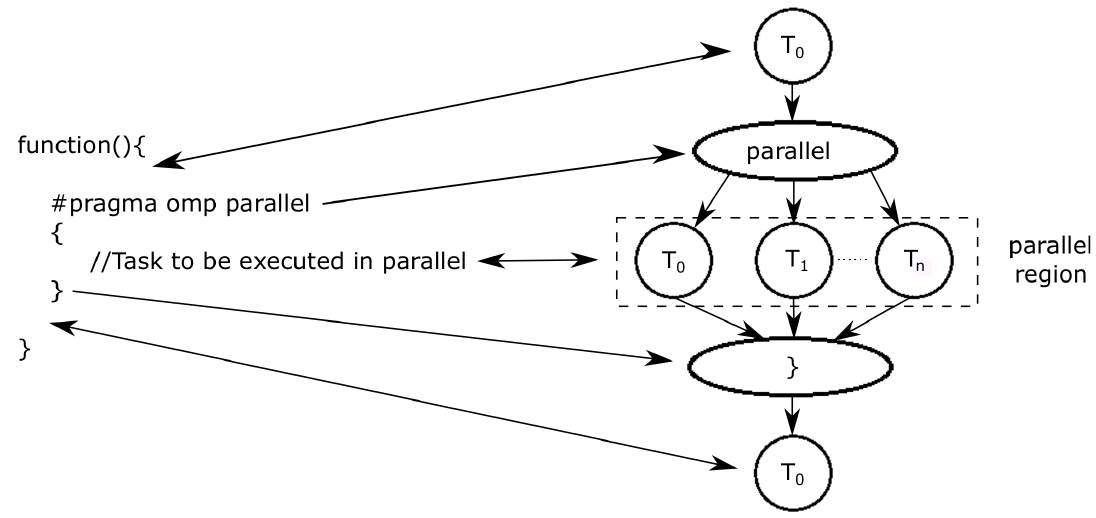
Figure 3. OpenMP API. The master thread is indicated with T 0 , while inside the parallel region the slave threads are T 0 , T 1 and T n